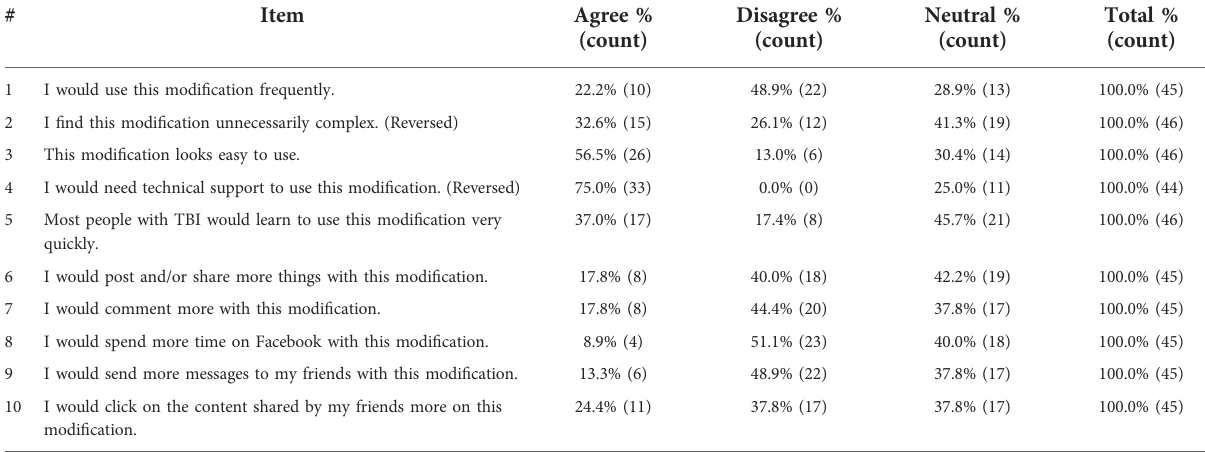
TABLE 5 Summary of participants ’ responses for social cue interpretation